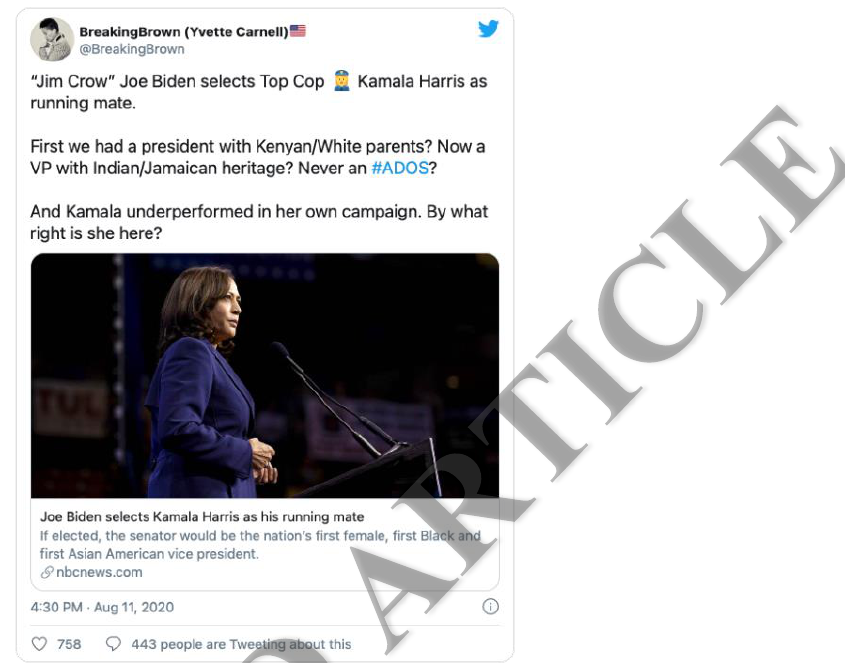
Figure 5. A tweet from Yvette Carnell, about how Kamala Harris’ immigrant heritage means she, along with Barack Obama, does not represent native-born Black Americans and that her elevation is a further snub, on August 11,